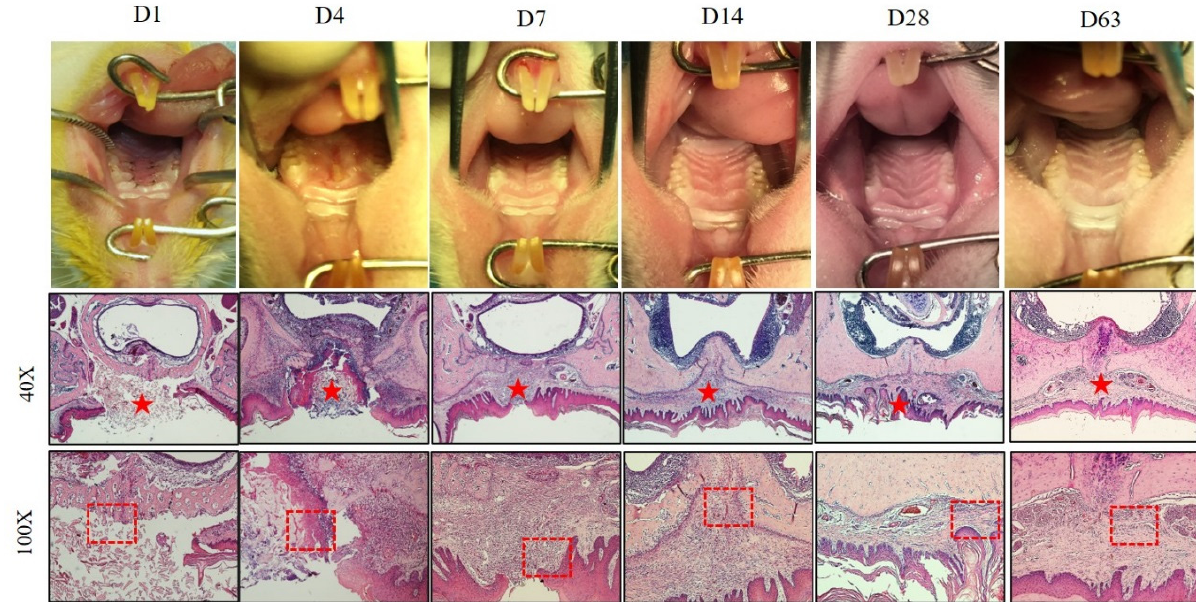
Figure 6. The postoperative recovery process and the representation of histological findings stain in the group using ADM to cover the bone denudation. In the ADM group, no noticeable scar was found on the palate nine weeks postoperatively. The healing process was finished around Day 28. Seven days after surgery, granulation tissue formation and angiogenesis were found between materials gaps, and epithelial cells migrated on the surface of ADM. Fourteen days after surgery, epithelial cells migrated on the surface of ADM, and blood vessels were reduced. Twenty-eight days after surgery, collagen fibers are arranged horizontally. The red stars represent the location of ADM; the red rectangles represent the junction of material and normal tissue junction.